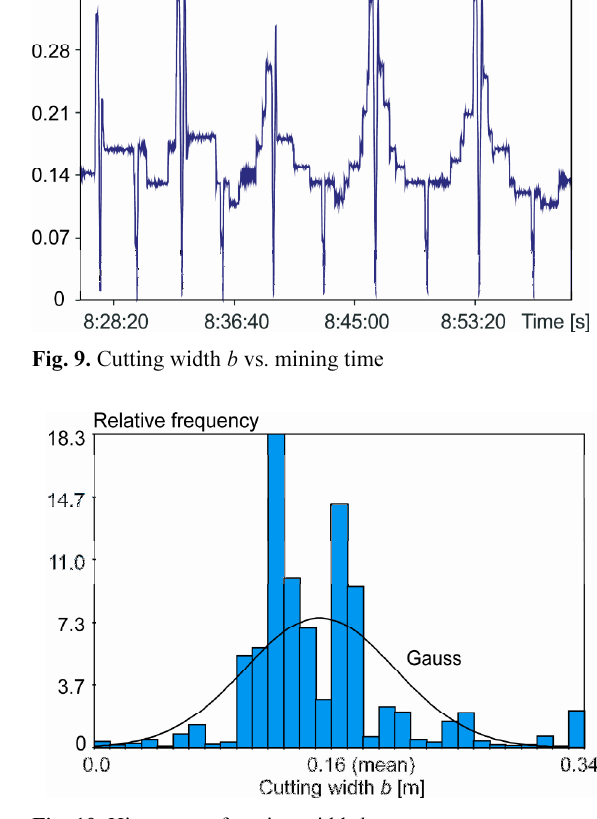
Fig. 10. Histogram of cutting width b